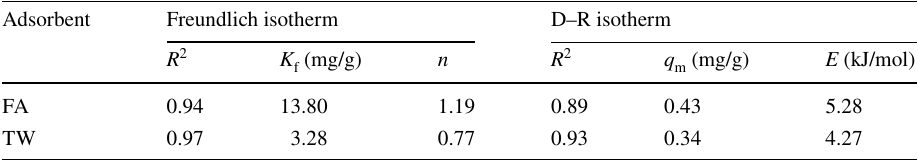
Table 5 Comparison of maximum adsorption capacity reported in the present study with the literature reported values